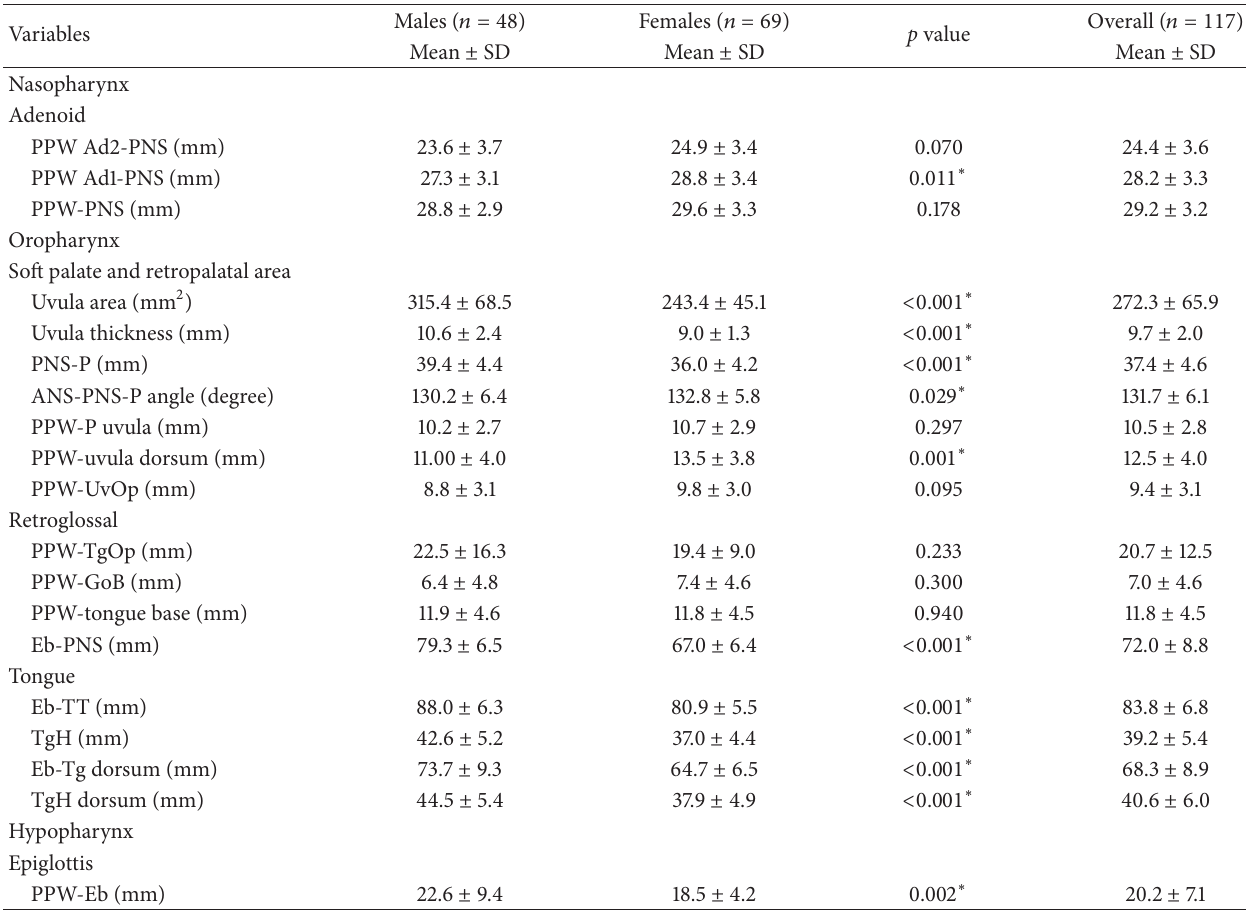
Table 1: Descriptive analysis of the selected cephalometric pharyngeal airway space variables in the sample population and comparison between genders. ∗ refers to statistically significant differences between